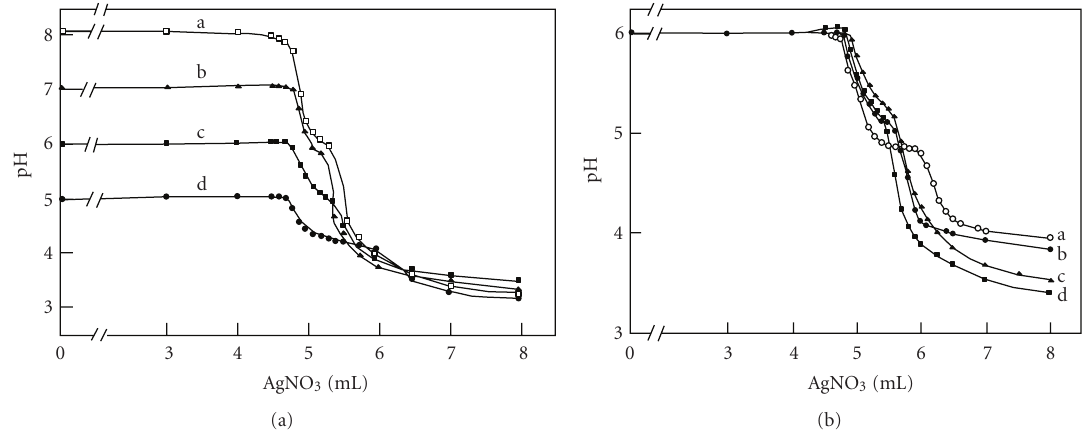
Figure 2: (a) Potentiometric titration curves for 25.0mL of 0.10M NaCl with 0.50M AgNO 3 in the presence of 3.2mM EDTA at various starting pH values: (a) 8.1, (b) 7.0, (c) 6.0, and (d) 5.0. (b) Titration curves for 25.0mL of 0.10M NaCl with 0.50M AgNO 3 at various concentrations of EDTA: (a) 0.70, (b) 3.2, (c) 6.3, and (d)